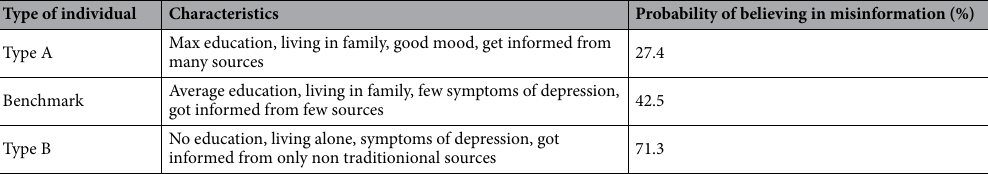
Table 3. Probabilities of believing in misinformation for types of citizens. *The estimates in the table refer to a probit panel data model (i.e., model I Table 1), with robust standard errors.